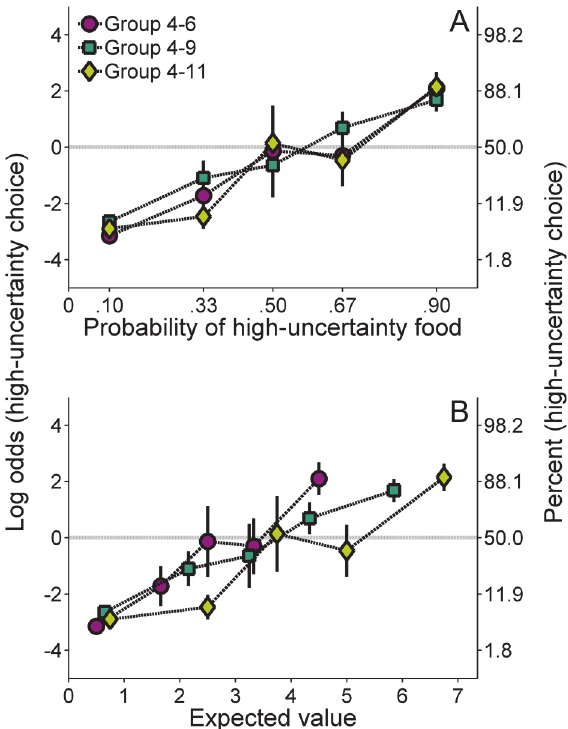
Fig 4. Mean ( ± SEM) log odds of high-uncertainty choices for each group in Experiment 2 as a function of the probability of high-uncertainty food delivery (A) and the expected value of a high-uncertainty outcome (B). A second ordinate showing percentages corresponding to the log odds values is included to aid interpretation.